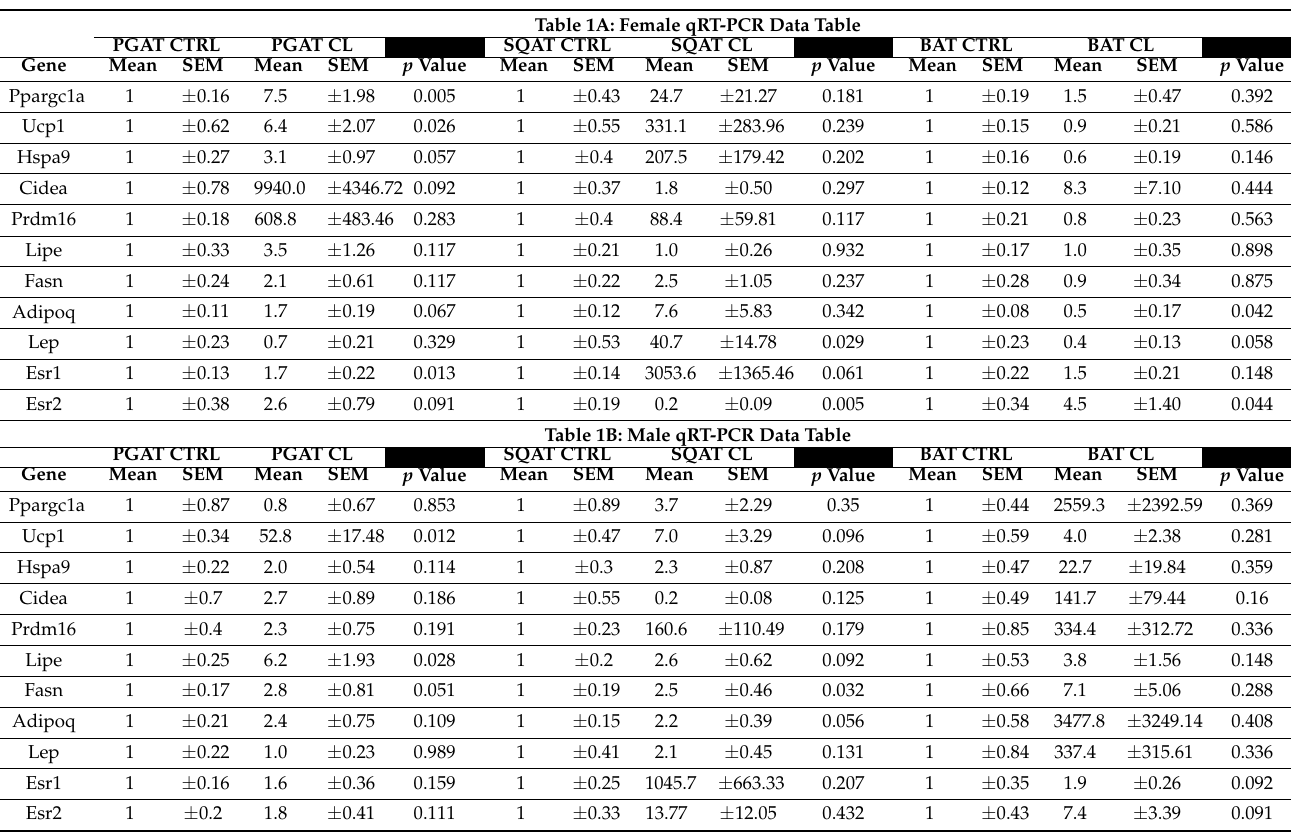
Table 1. Male (M) and female (F) C57BL/6J mice, all on HFD, were given a 2-week CL injection (1 µ g/g body wight) or CTRL (saline). Table 1A: Female qRT-PCR Data Table PGAT CTRL